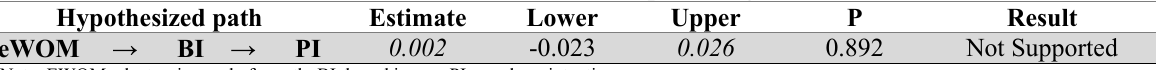
Results of the structural model for the indirect relationships among constructs Hypothesized